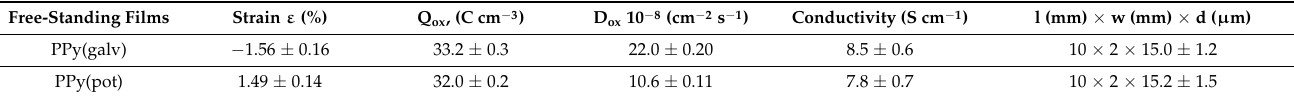
Table 1. Strain (negative strain refers to expansion on reduction), charge density on oxidation Q ox , and diffusion coefficient on oxidation D ox at 16.7 mHz with sample dimensions and conductivities of PPy(galv) and PPy(pot) free-standing films (mean values).